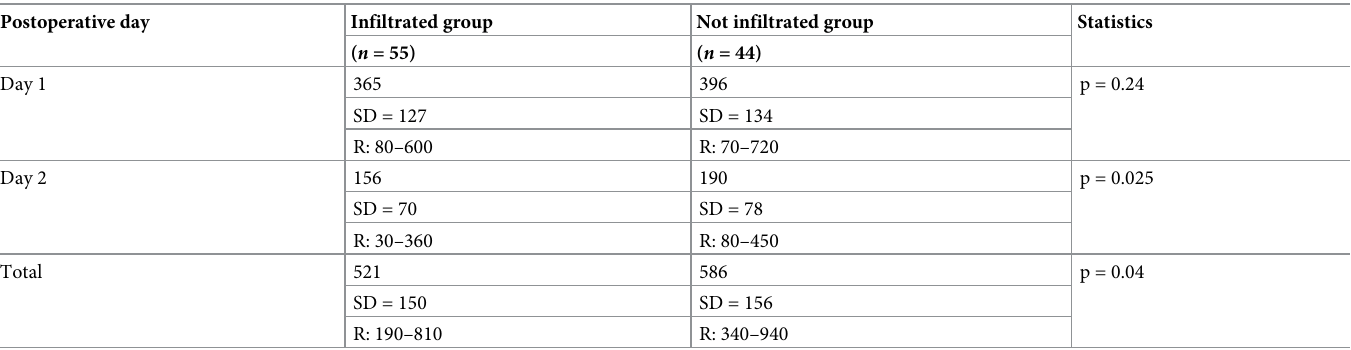
Table 4. Drainage output volume in milliliters.